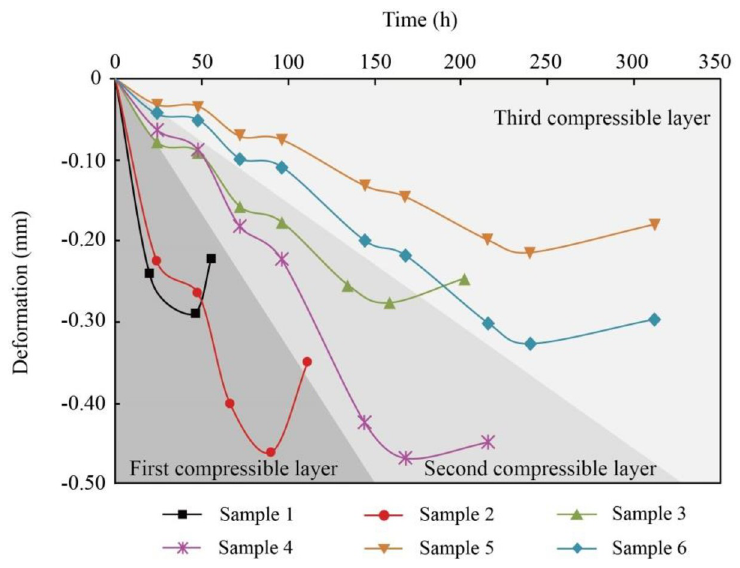
Fig 11. Deformation in the whole process of withdrawal and recharge for each soil